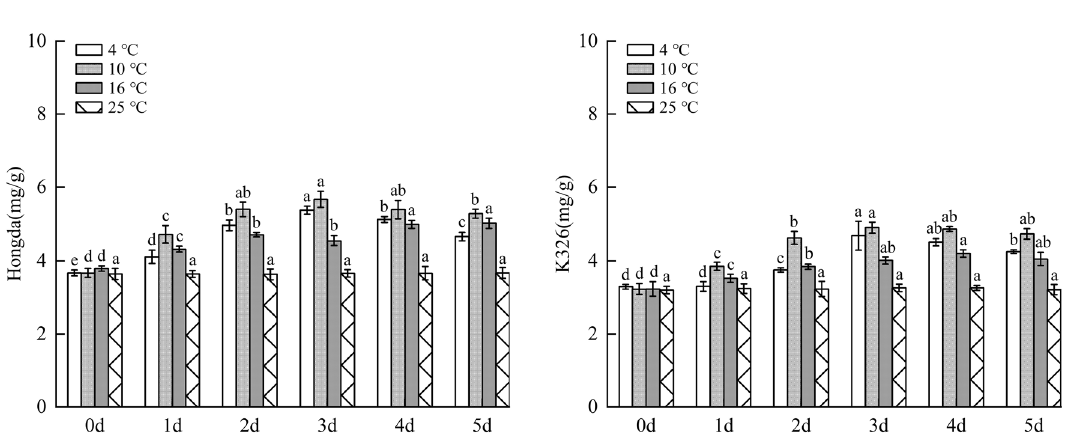
Figure 15. The changes of total phenol content under different low-temperature stresses. Different lowercase letters indicated that there were significant differences at different times under the same temperature treatment (P < 0.05).The values were the mean of three biological